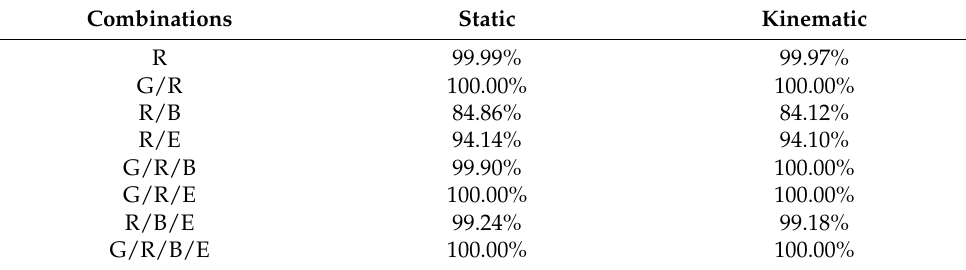
Table 19. Data utilization of the EG model (based on the QF model). Combinations Static Kinematic R 99.99%